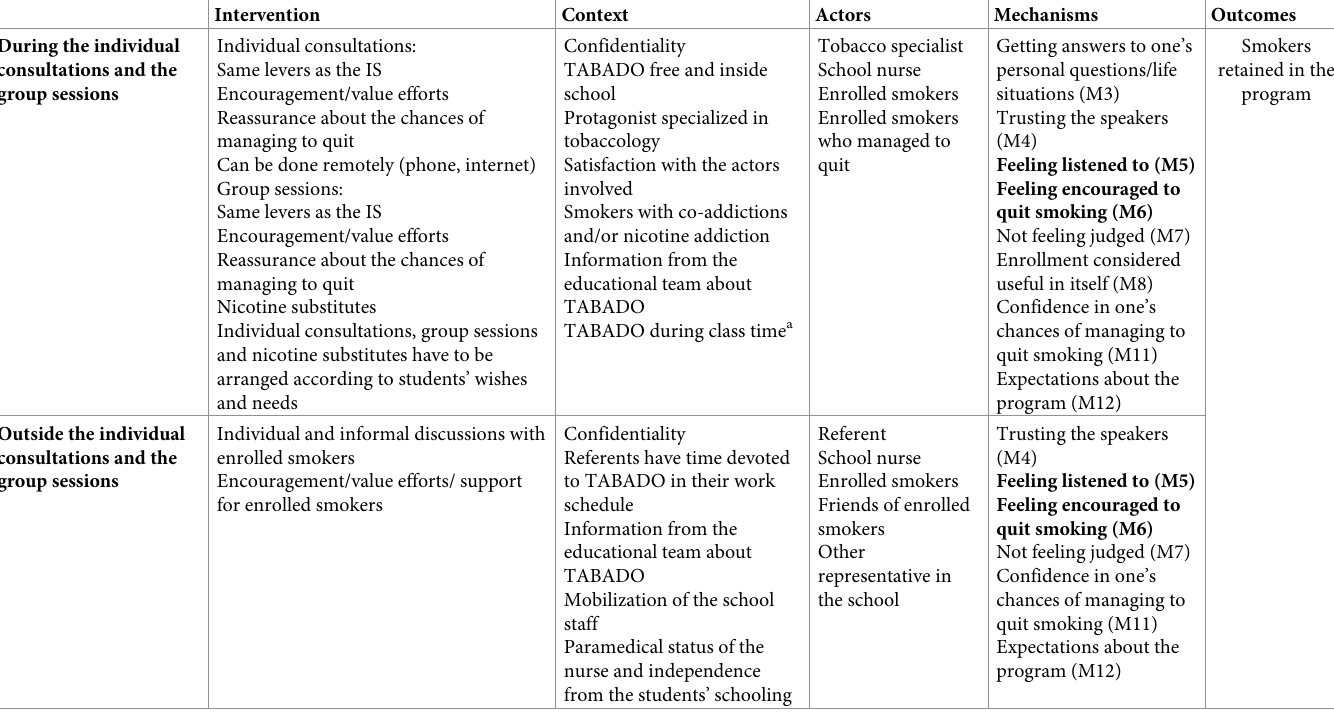
Table 4. ICAMO configurations for keeping smokers in the TABADO program. Intervention Context Actors Mechanisms